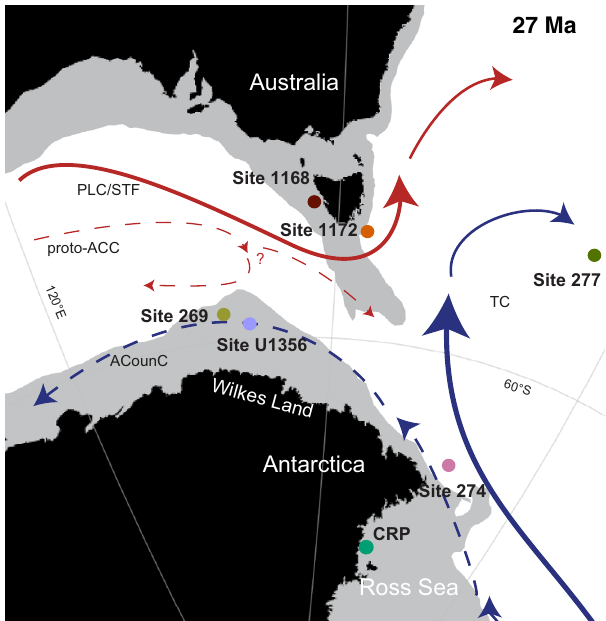
Fig. 1 Paleogeographic map of the Oligocene locations of study sites and prevailing ocean currents. The approximate paleogeography at 27 Ma is reconstructed through G-plates (http://www.gplates.org), based on the global geodynamic rotation model from Müller, et al. 70 . Black represents the outline of modern coastlines. The grey outline corresponds to the modern 2000 m water depth contour. PLC Proto-Leeuwin Current, STF Subtropical front, TC Tasman Current, proto-ACC proto-Antarctic Circumpolar Current and ACountC = Antarctic counter current (after Houben, et al. 3